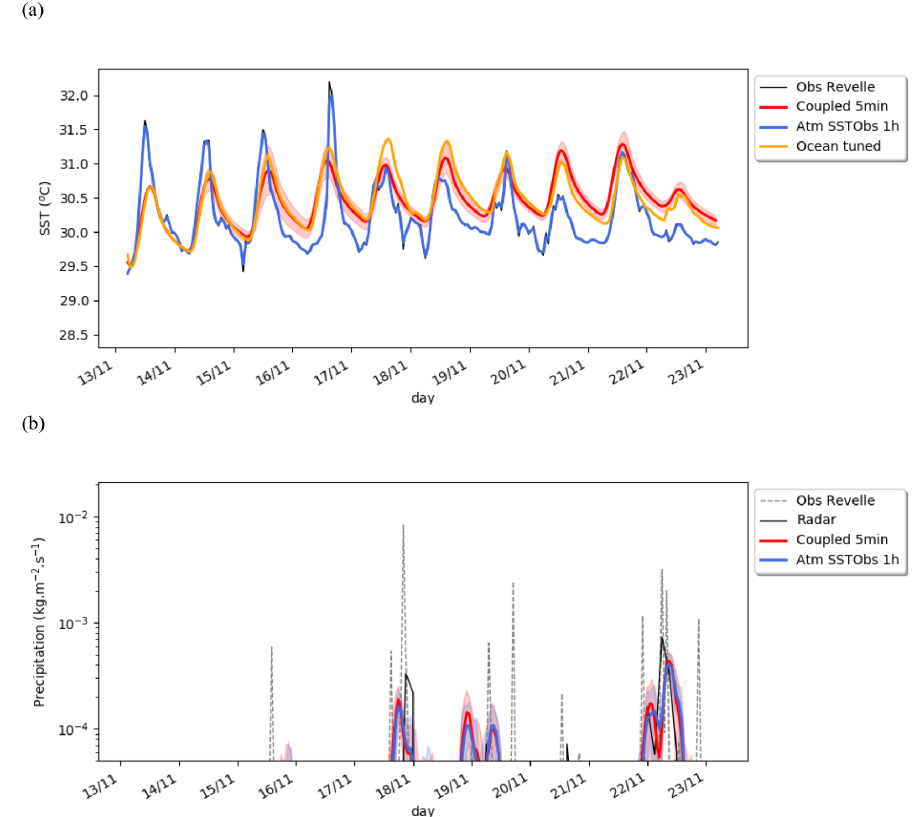
Figure 10. Hourly time series of (a) surface temperature ( ◦ C) for the coupled experiment (in red), the reference atmospheric (blue) and ocean forced (orange) experiments along with observations at the position of the R/V Revelle (black), and (b) precipitation (kgm − 2 s − 1 ) for the coupled (in red) and the reference atmospheric (blue) experiments along with local observations at the position of the R/V Revelle (dashed grey) and radar estimates (black). The shading represents 2 standard deviations of the inter-member